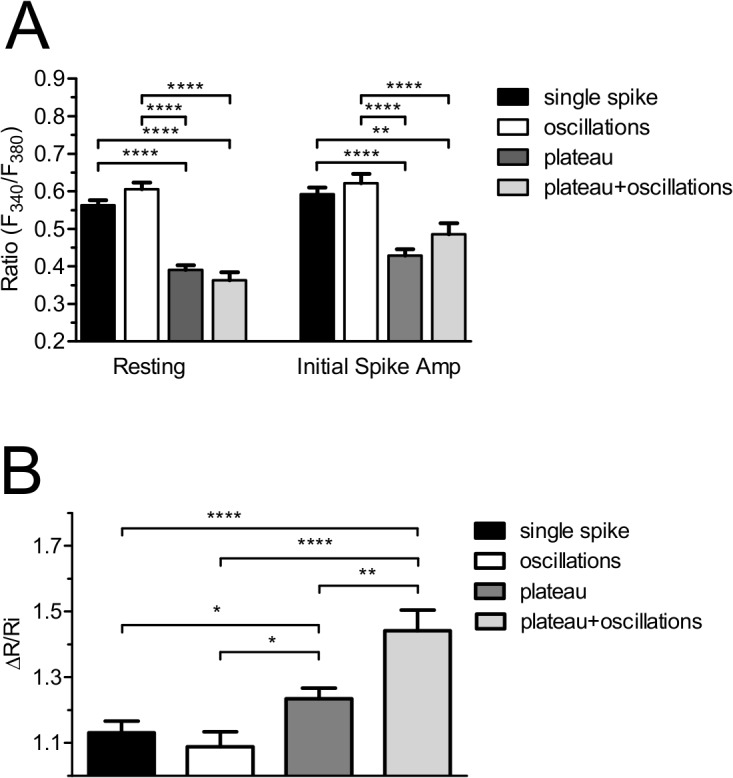
The pattern and initial spike-amplitude of the Ca2+ response to beractant depend on resting [Ca2+]i.
A) Resting [Ca2+]i measured in quiescent, non stimulated Fura-2 loaded NHLF that presented the correspondent Ca2+ signal pattern indicated in labels in response to beractant (left). Amplitude of the initial Ca2+ spike evoked by beractant (right). B) Initial spike amplitude/basal [Ca2+]i (ΔR/Ri; ΔR was defined as the difference between the peak [Ca2+]i after stimulation and the value of the resting [Ca2+]i, where Ri is the basal level of R). Results, expressed as means ± SE were analyzed statistically by Student's t test. ** p <0.01, **** p <0.0001.